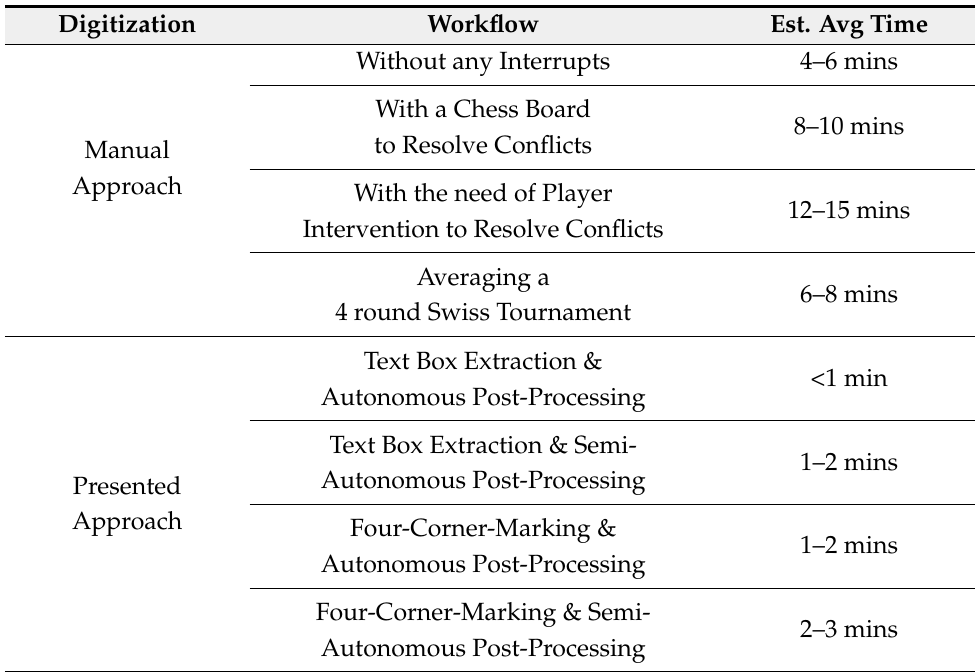
Table 4. Timing estimation for digitization of handwritten chess scoresheets with different ap- proaches and scenarios. Numbers presented are obtained from a small-scale research and voluntary